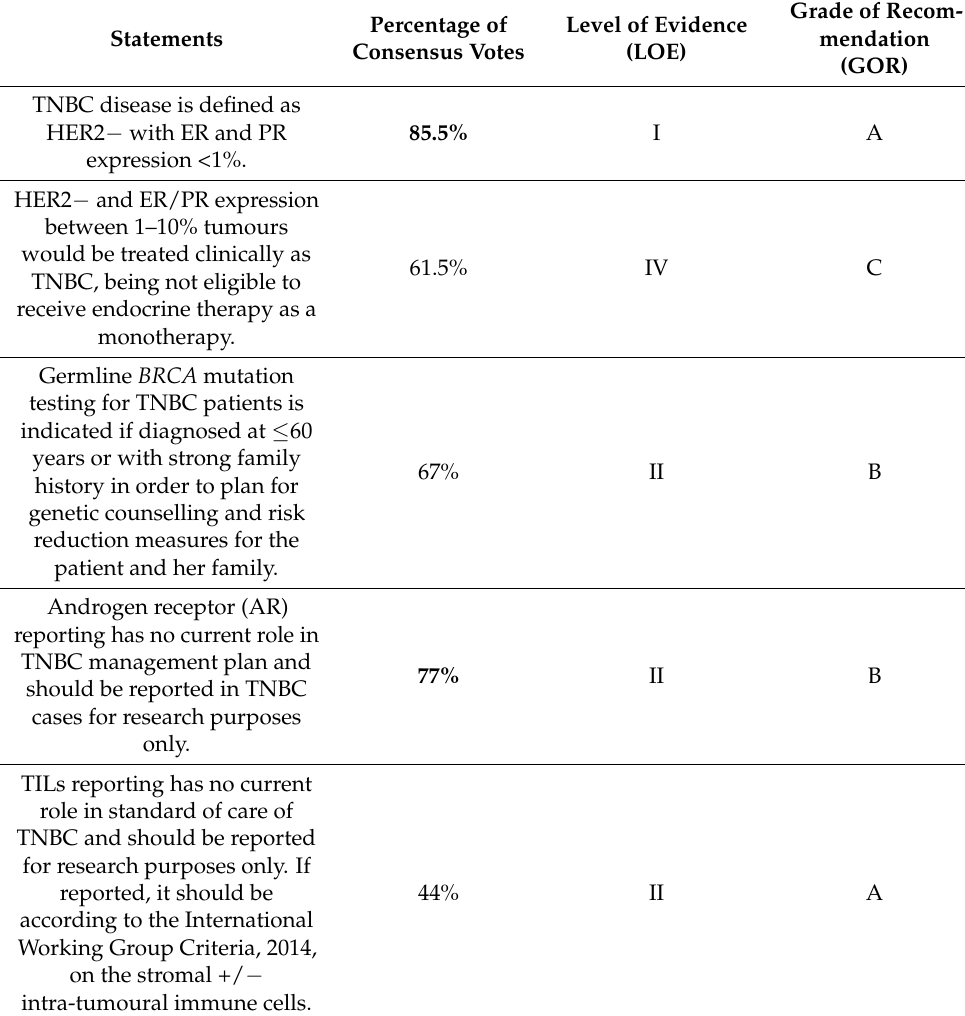
Table 4. Levels of evidence and grades of recommendation of the consensus meeting